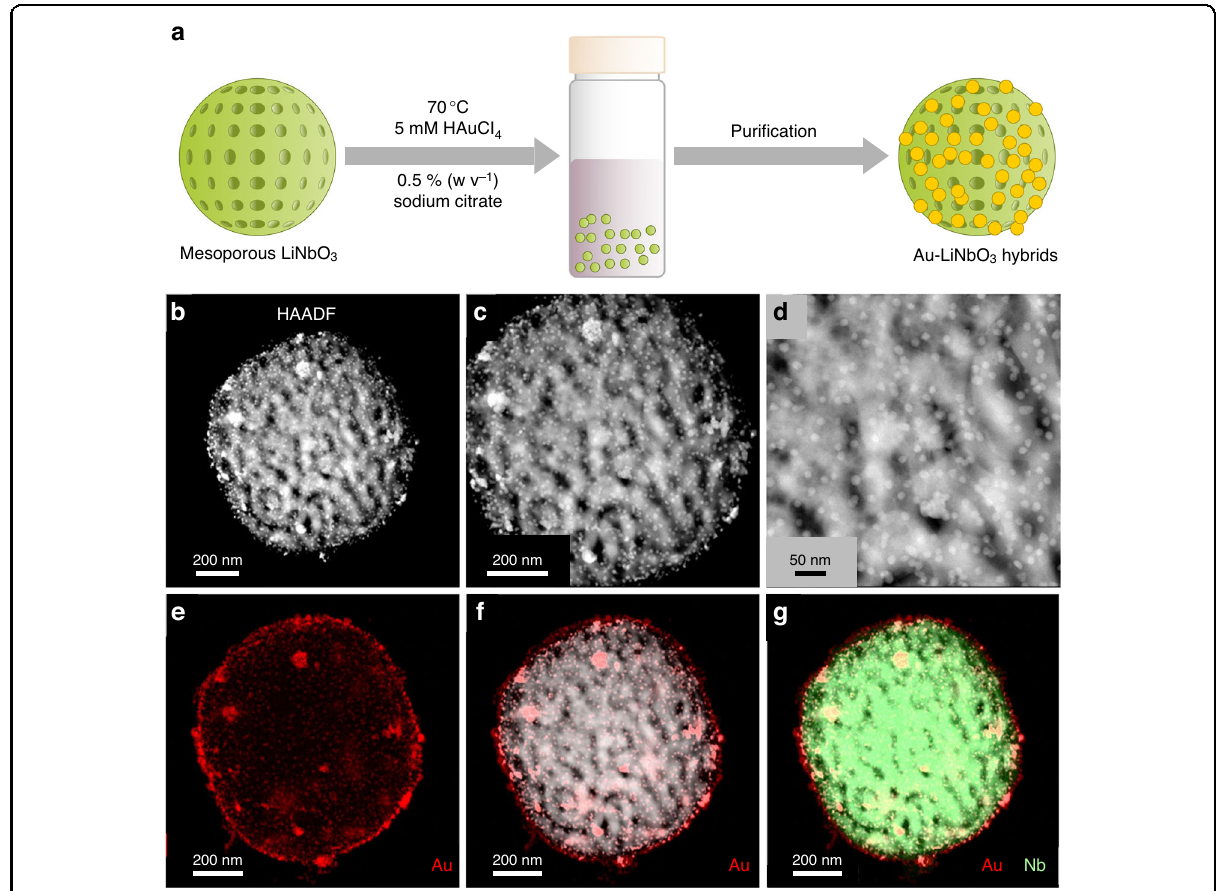
Fig. 1 Synthesis of hybrid Au – LiNbO 3 nanostructures. a Representative schematic to prepare the hybrids of Au NPs with LiNbO 3 as achieved using an in situ synthesis method. Assemblies of Au – LiNbO 3 hybrid particles as characterized by scanning transmission electron microscopy (STEM) operating in: b , c , d a high-angle annular dark- fi eld (HAADF) mode. Energy dispersive X-ray spectroscopy (EDS) analysis of the Au – LiNbO 3 hybrids obtained by STEM techniques was used to create EDS maps of: e Au NPs; f Au NPs overlaid on the HAADF image of the assemblies; and g overlaid Au-Nb signals within these